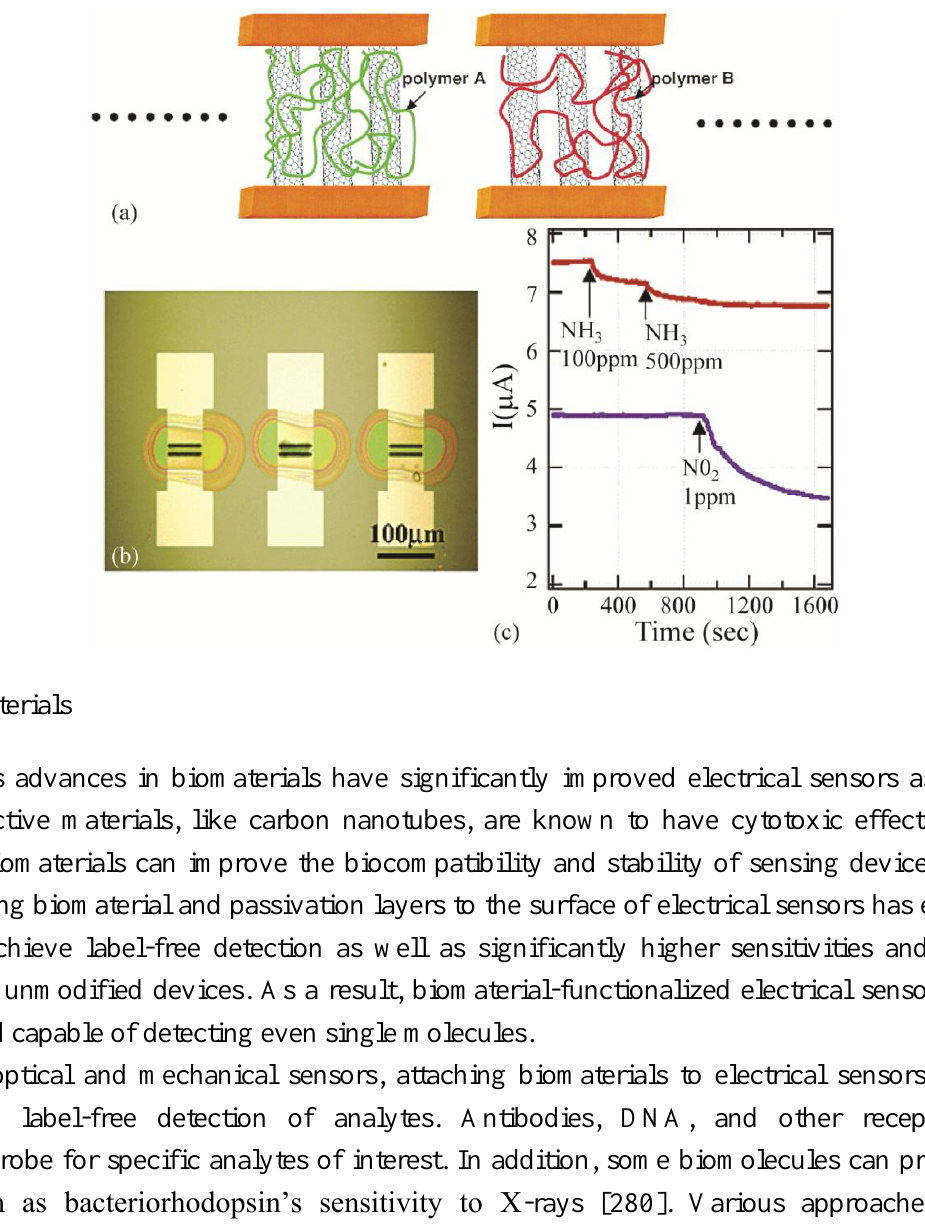
Figure 8. ( a ) Schematic of SWNT sensor. In the present work, Nafion and PEI are the polymers used; ( b ) Optical image of three sensors after coating with droplets of polymer solutions; ( c ) Comparison between the Nafion coated and the PEI-coated devices: The red (top) curve is the response of a Nafion coated device which shows response to 100 ppm and 500 ppm of NH in air and no response when 1 ppm NO was injected. The blue 3 2 (bottom) curve is the response of a PEI-coated device which shows no response to 100 ppm and 500 ppm of NH and a large drop in conductance to 1 ppm of injected NO . Adapted 3 2 with permission from reference [276] © 2003 American Chemical